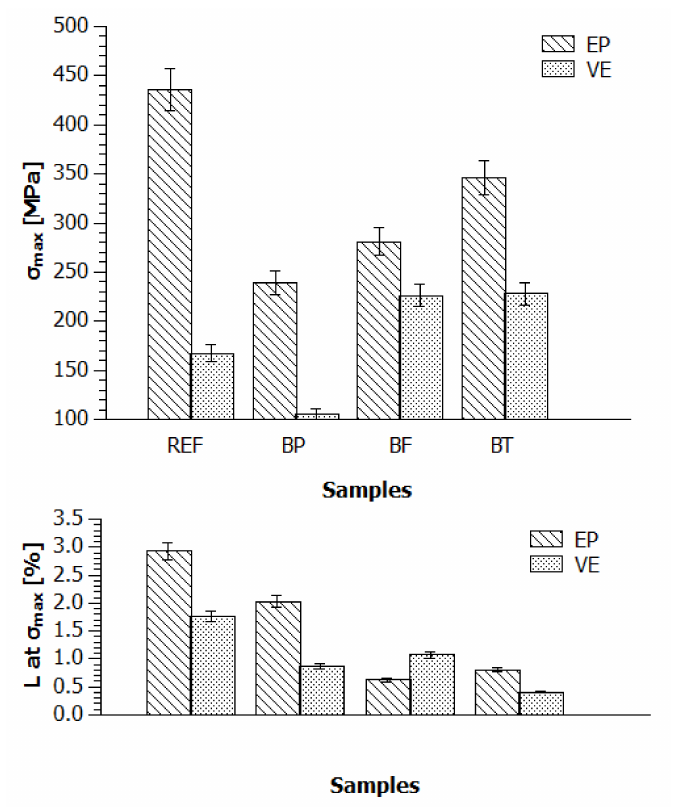
Figure 3. Relation between σ max and corresponding elongation at maximum stress point (L at σ max ) for composites EP and VE reinforced with basalt powder (BP), basalt fibre (BF) and basalt textile (BT) based on the measurements taken at 25 ◦